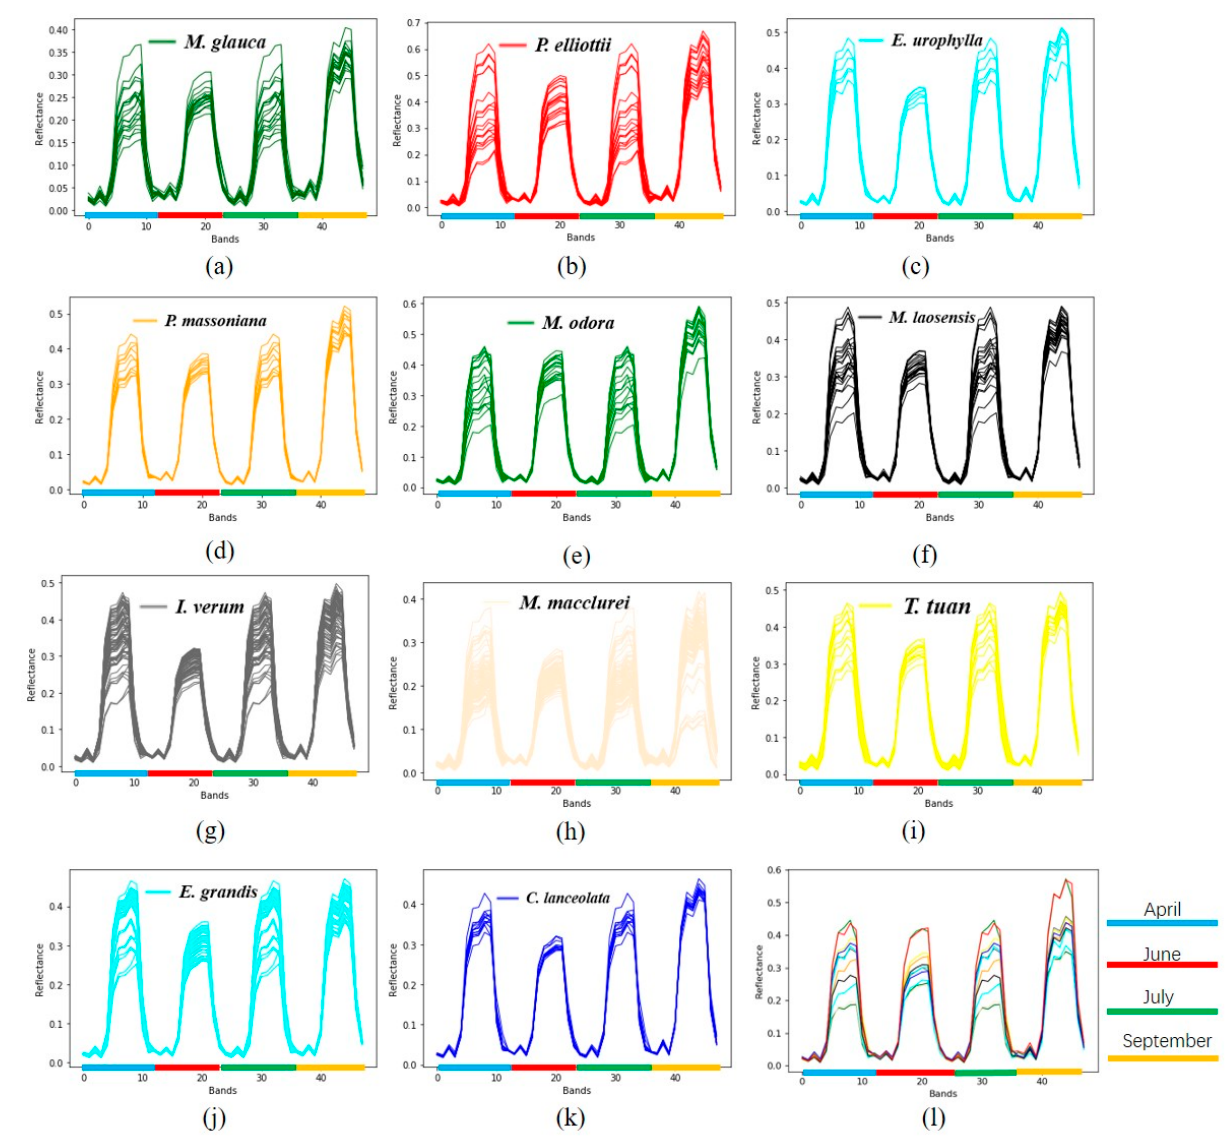
Figure 13. ( a – k ) The spectral curve of time-series image of 11 tree species, and ( l ) a comparison chart of the curves for 11 tree species, shows the curves of the time series of eleven tree species.